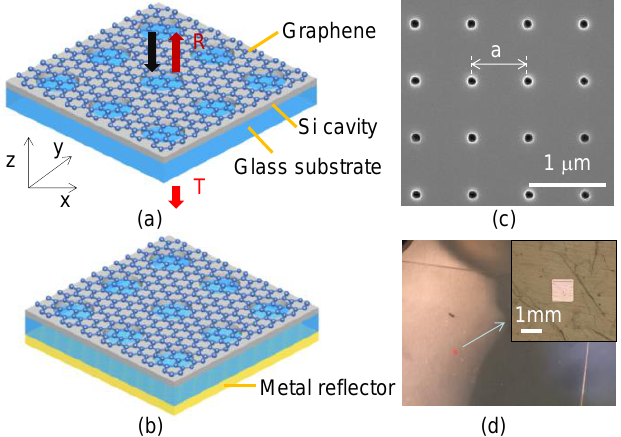
Figure 14. Schematics of graphene on Si photonic crystal cavity ( a ) without and ( b ) with a back metal reflector; ( c ) a SEM top view image of the fabricated Si photonic crystal slab on SOI substrate; and ( d ) A micrograph of the device under study here with a tri-layer configuration (monolayer graphene/Si photonic crystal slab/glass substrate) via two step transfer printing processes. Reproduced with permission from